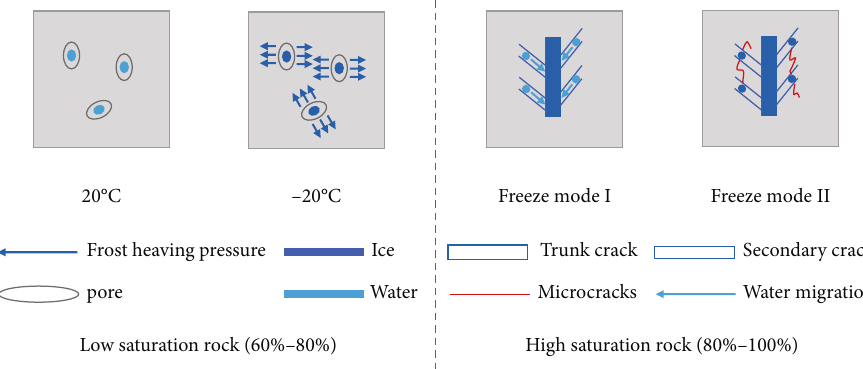
Figure 13: Mesoscopic freeze-thaw damage mechanism under the in fl uence of di ff erent saturations.